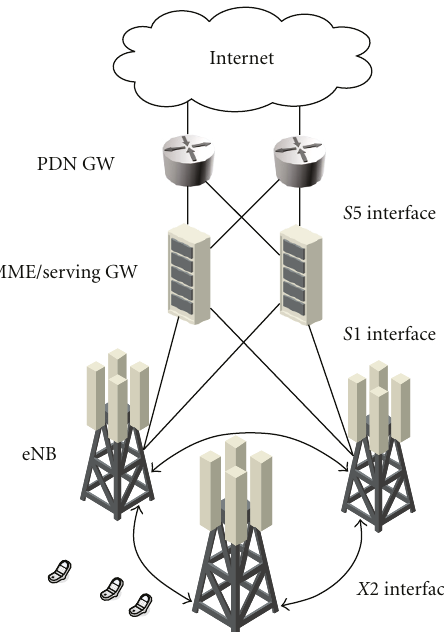
Figure 1: LTE Release 8